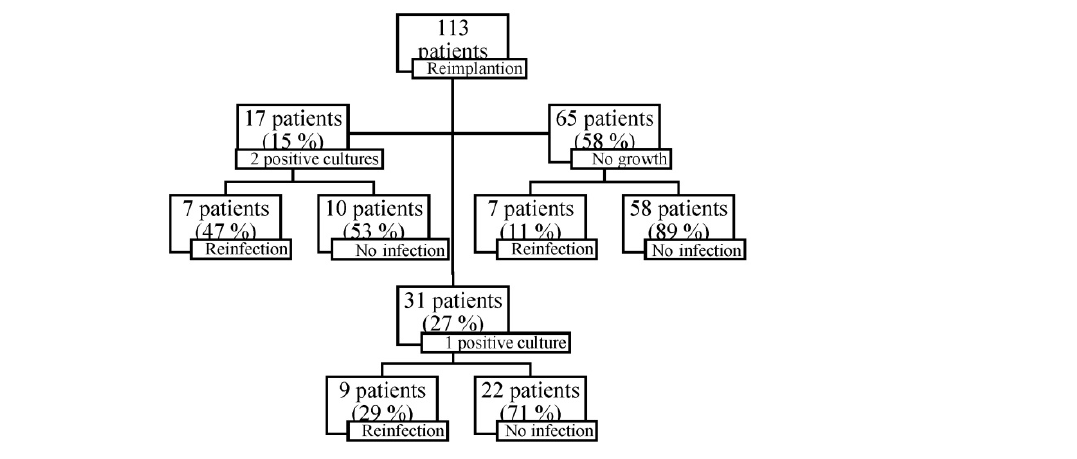
Figure 4: Reinfection rates divided by culture results at